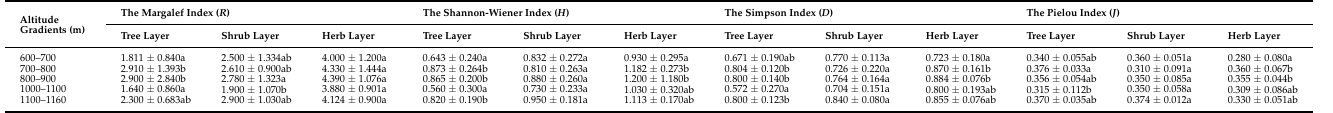
Table 9. Species diversity index of plant communities at different altitude gradients.